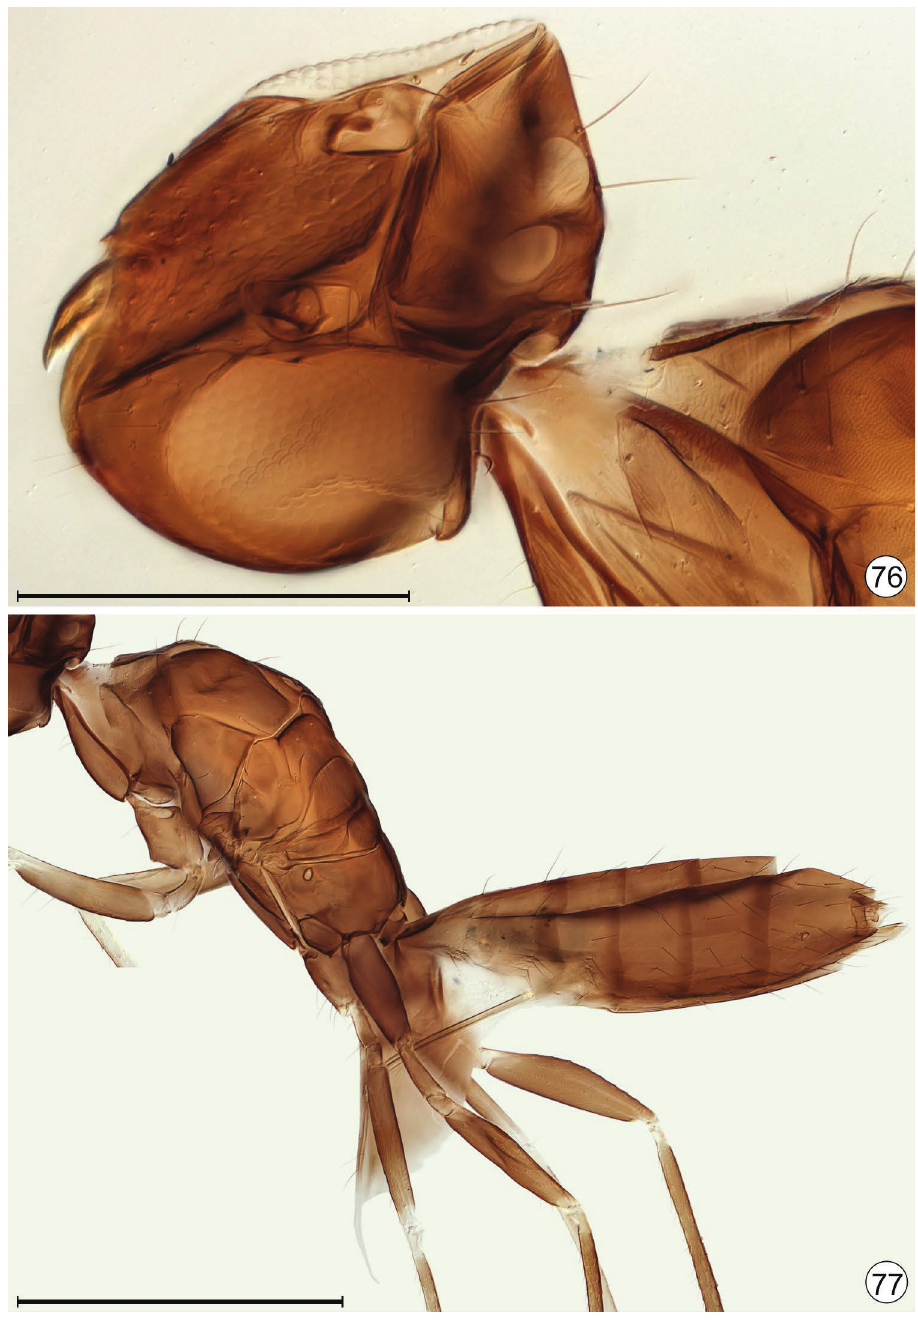
Figures 76, 77. Neotriadomerus crassus , holotype. 76 head + anterior of mesosoma, dorsolateral 77 meso- soma + metasoma (ovipositor broken off near base of hypopygium), dorsolateral. Scale bar for 76 = 200 μm; 77 = 500